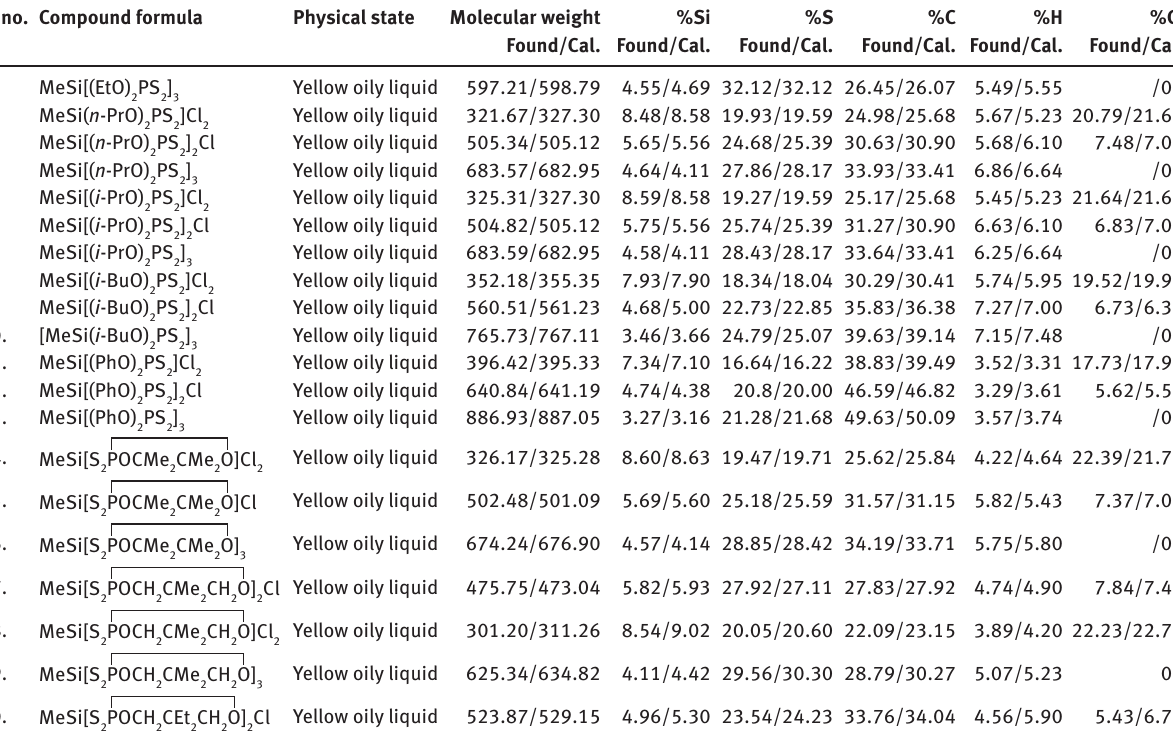
Table 1: Physical data of methylsilicon (dialkyl and alkylenedithiophosphate) derivatives. S. no. Compound